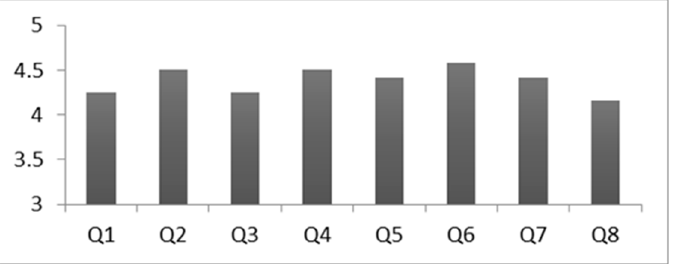
Figure 23. Average ratings of participants’ attitude concerning the learning experience offered by the ARtful mobile app.